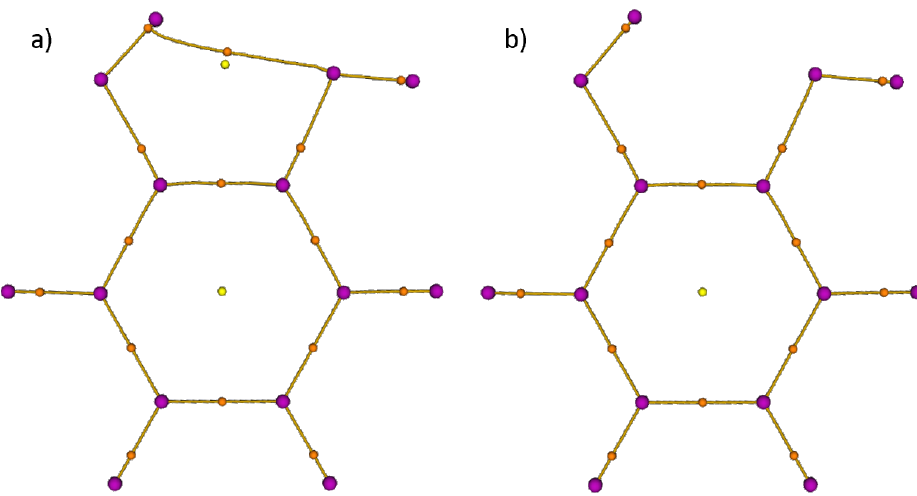
Figure 2. Topological analysis of the electron density of the global minimum A of catechol analysed by the Multifunctional Wavefunction Analyzer (Multiwfn) [22]. Purple, orange, and yellow dots are, respectively, the local maxima localized on the atoms, bond critical points, and ring critical points of the electron density. The B3LYP functional and different basis sets were used: ( a ) the intramolecular HB is visible with a cc–pVDZ basis set; ( b ) with diffuse functions and/or a larger basis set (aug–cc–pVDZ/cc–pVTZ/aug–cc–pVTZ), no intramolecular HB is